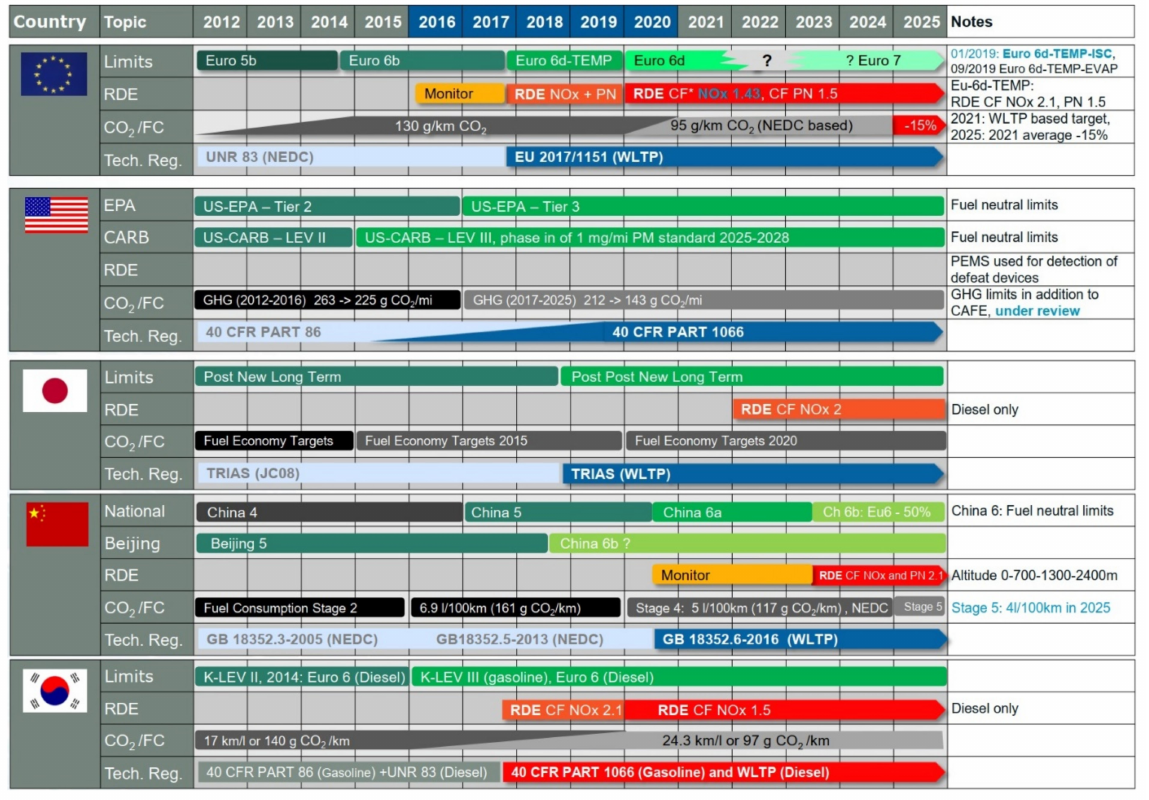
Figure 2. Timeline of emissions standards for passenger cars in different parts of the world